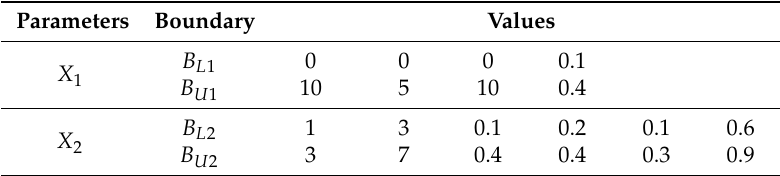
Table 2. The boundaries of decision variables.